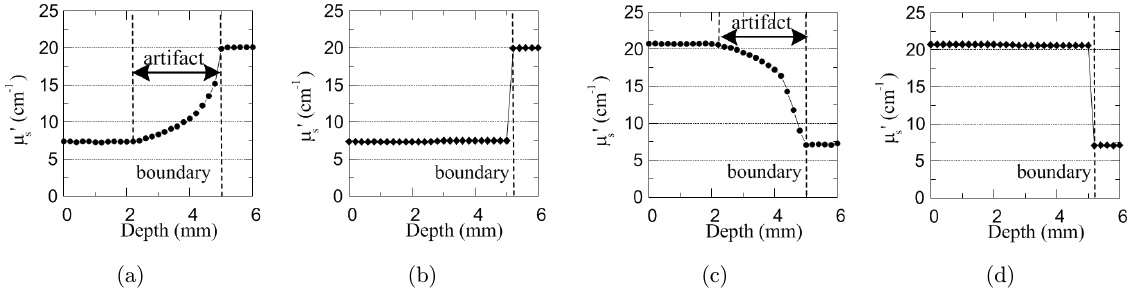
Fig. 7. The (cid:1) 0 s curves of two-layer models (a) the measured data of Up 4 model (b) the processed data of Up 4 model (c) the measured data of Dn 4 model (d) the processed data of Dn 4 model.